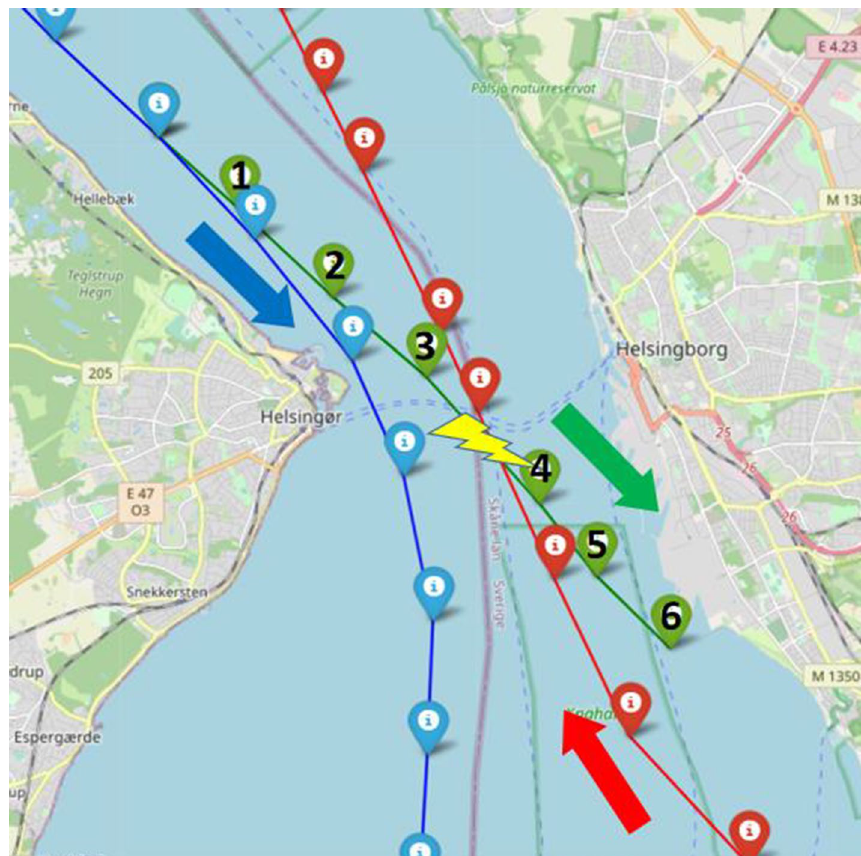
Fig. 13 Visualization of improved ship trajectory prediction (green trajectory) based on Stacked-BiGRUs. Firstly, we train a Stacked-BiGRUs trained on the Baltic Sea summer ship trajectory dataset and use the trained model to predict the trajectories of the two encountering ships. The prediction results of the two encountering ships by the pretrained model are shown in this figure. The blue trajectory in the figure is the historical trajectory of the blue ship, and its route direction is the direction of the blue arrow. Besides, the red line is the red ship’s historical trajectory, and the sailing direction is the along the red arrow. The green trajectory is the predicted trajectory of the blue ship from a certain